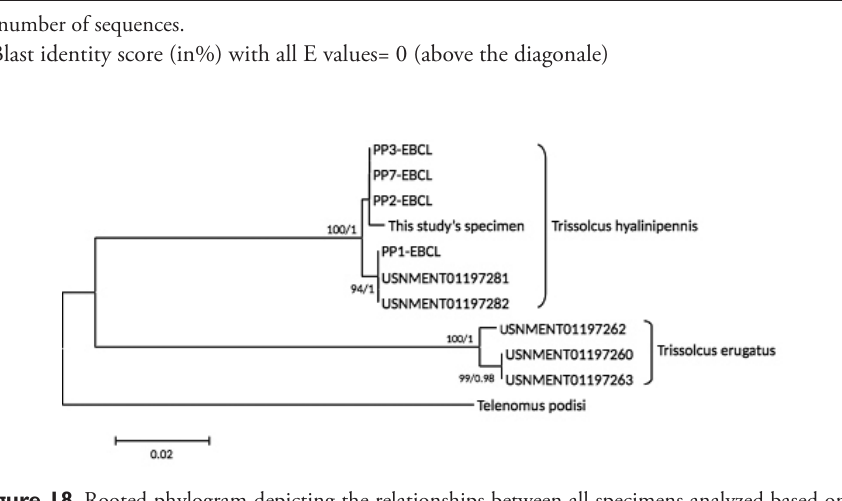
Figure 18. Rooted phylogram depicting the relationships between all specimens analyzed based on the barcode dataset alignment. Bootstrap percentages (BP) ≥ 75 and Posterior Probabilities (PP)≥ 0.90 are indicated at nodes. Each line represents a sequenced specimen with reference to its collection